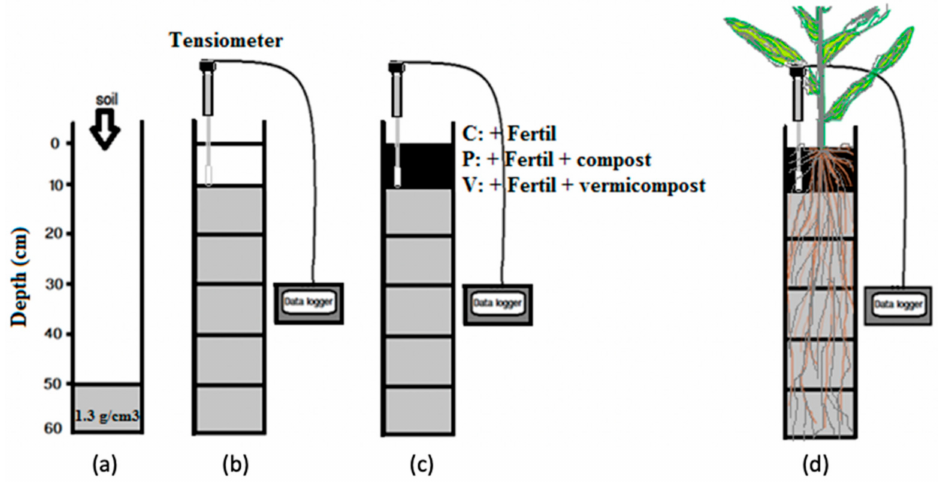
Figure 1. Preparation of soil columns: ( a ) soil was placed on the bottom of the column and gently packed to a 10 cm thick layer with a bulk density of 1.3 g cm − 3 . ( b ) Additional layers were added in the same way and a micro-tensiometer connected to a data logger was installed before adding the top layer. ( c ) The preparation of the top layer followed the same procedure after the addition of fertilizers (C, control treatment) or fertilizers plus organic amendments (P and V, compost and vermicompost treatments, respectively). ( d ) The experiment was stopped at 71 days after planting (DAP) when the roots reached the bottom of some